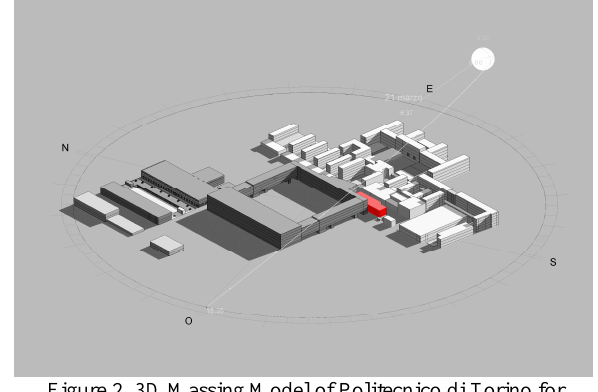
Figure 2. 3D Massing Model of Politecnico di Torino for shading study